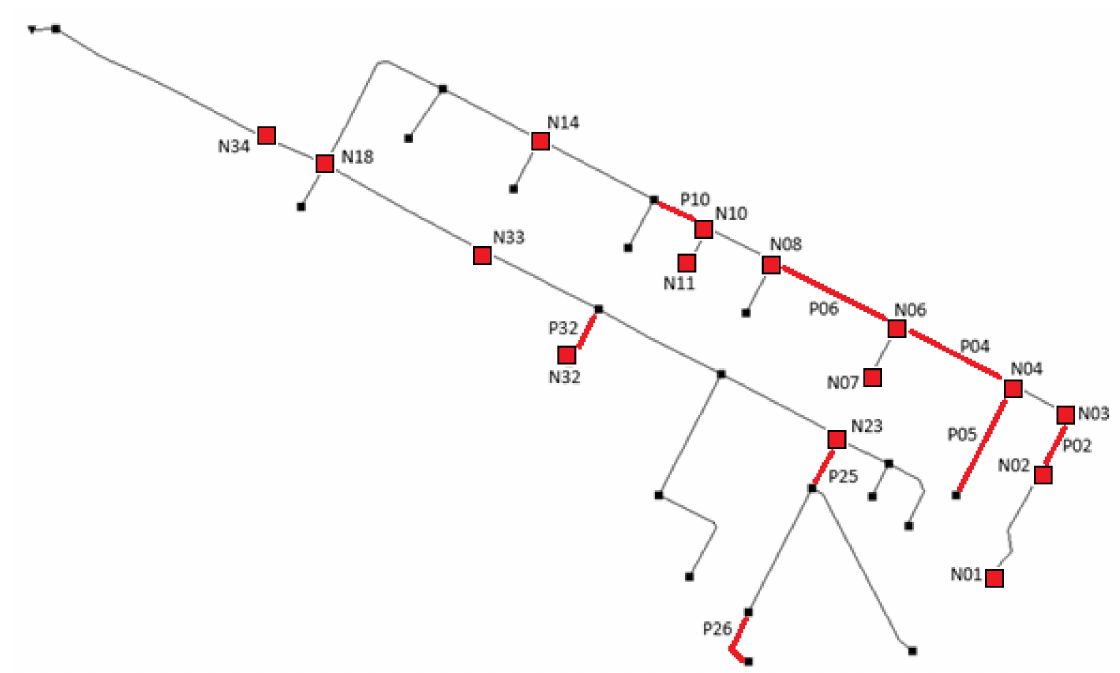
Figure 8. Nodes and pipes preselected in the Search Space Reduction (SSR) process.